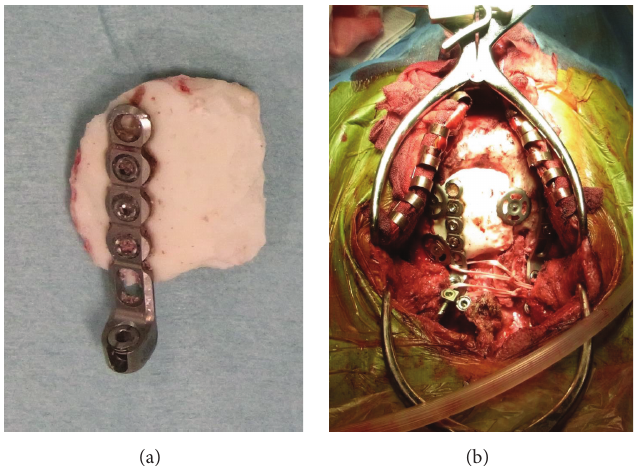
Figure 3: Intraoperative findings. A resin-made occipital bone was anchored with a titanium plate and titanium screws (a). Simultaneous cranioplasty and posterior fusion of the craniovertebral junction were performed. The iliac crest bone was grafted onto the occipital bone- C1-C2 alignment, and this grafted bone was fixed by a